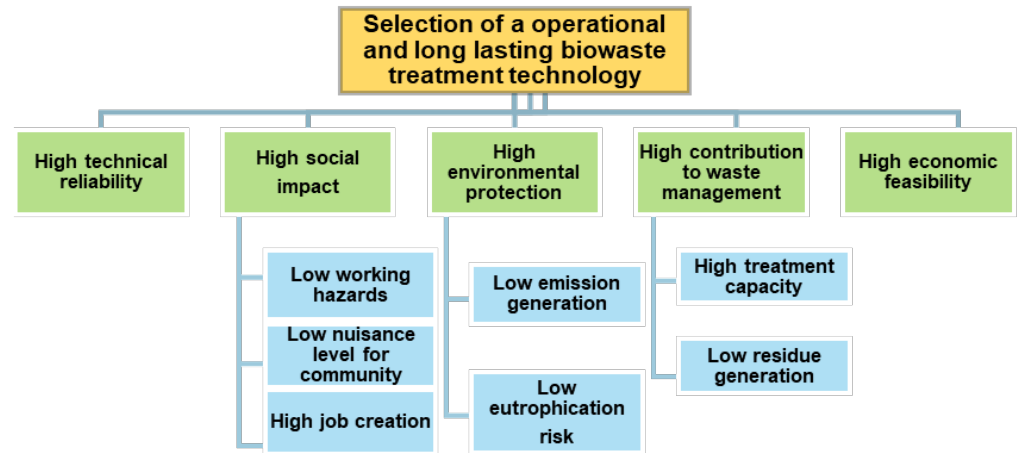
Figure 1. The default objective hierarchy defined by the SOWATT tool, adapted from